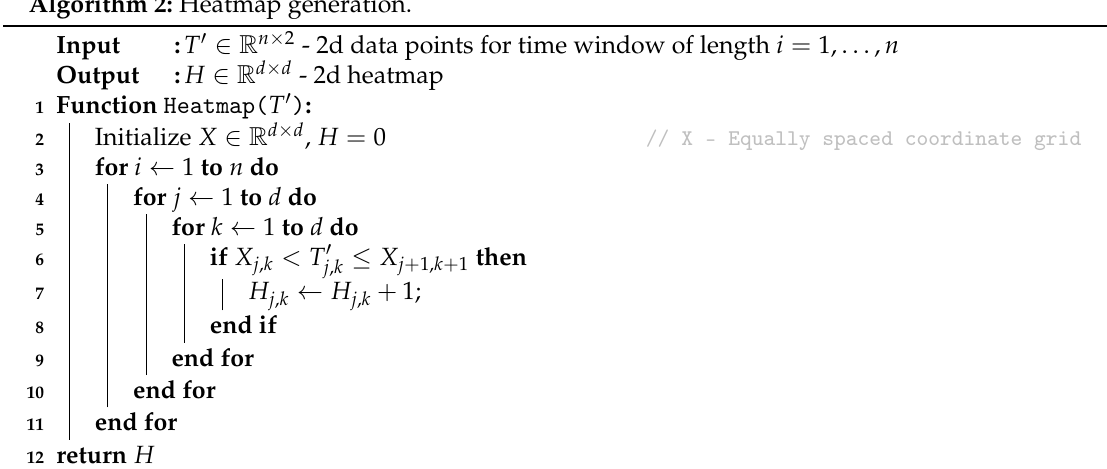
Algorithm 2: Heatmap